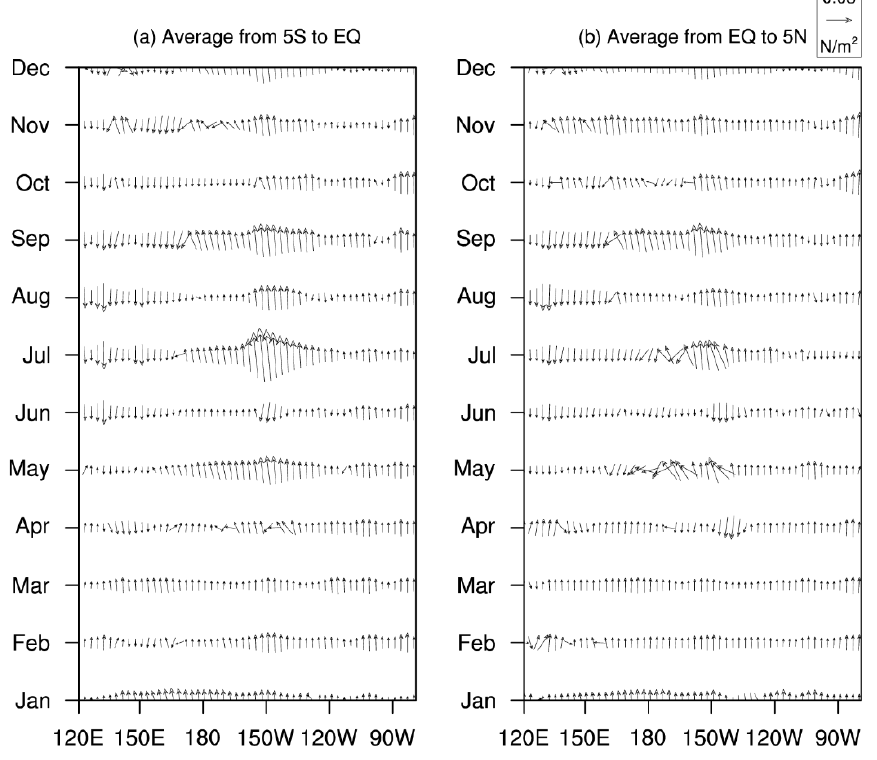
Figure 10. Zonal-time sections along ( a ) the south of the equator (averaged at 5° S – 0) and ( b ) the north of the equator (averaged at 0 – 5° N) for wind stress anomalies in 2021.